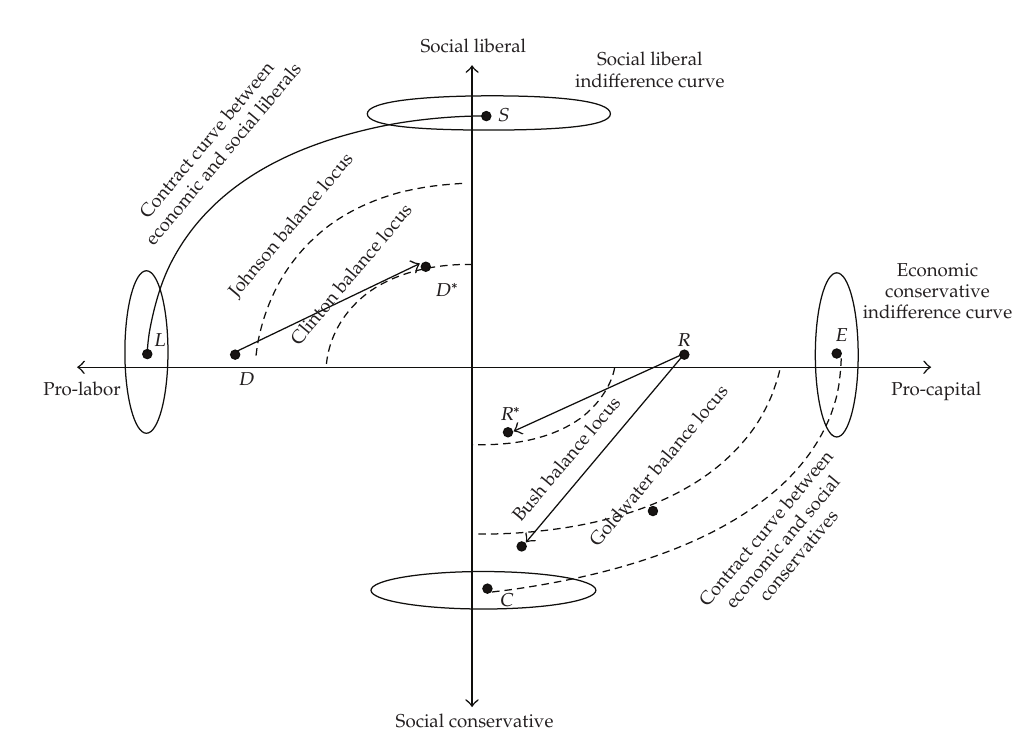
Figure 1: The balance loci in the United